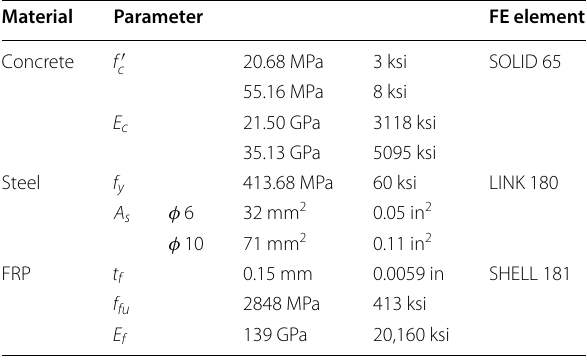
Table 1 Material properties and FE elements for the control (or unwrapped) column and the eight columns in Fig.